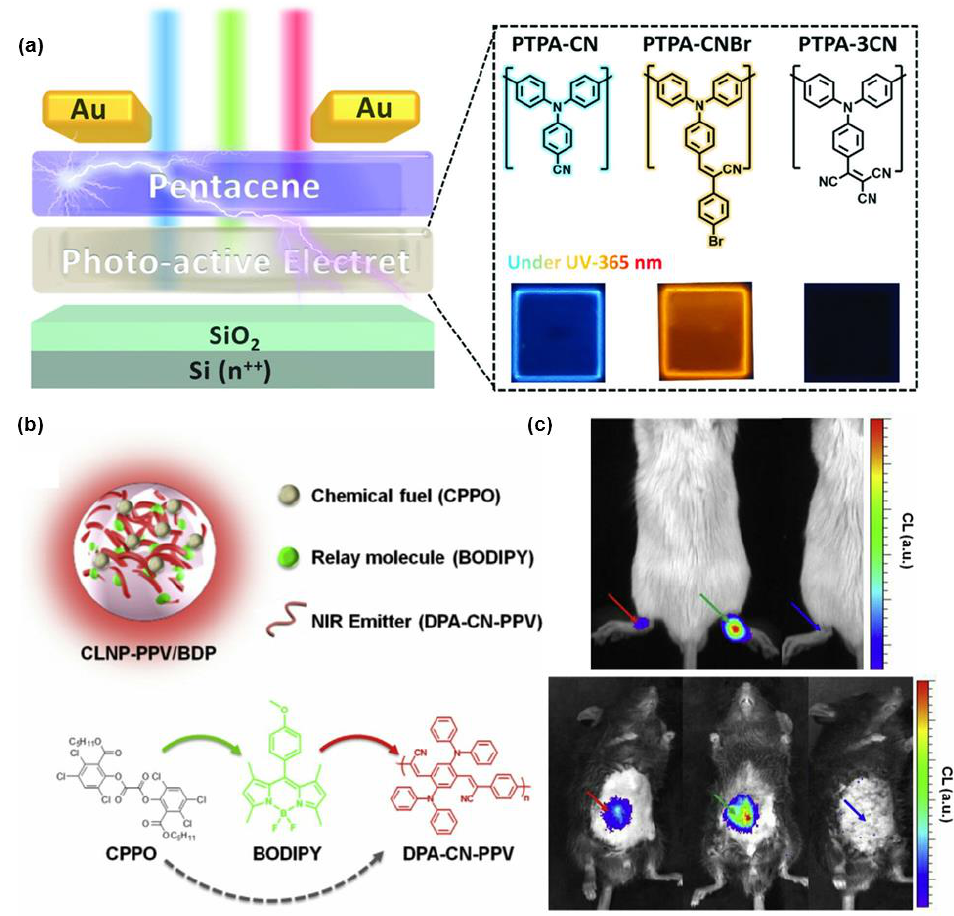
Figure 6. ( a ) The chemical structures of the relevant molecular and schematic illustration of pho- toprogrammable recorder device. Reprinted with permission from Ref. [44]. 2021, Wiley-VCH. ( b ) Schematic illustration of the structure of energy-relayed POCL nanoparticle (CLNP-PPV/BDP) and corresponding molecules. ( c ) The photographs of mouse model of arthritis and peritonitis. Re- printed with permission from Ref. [45]. 2016, Elsevier.